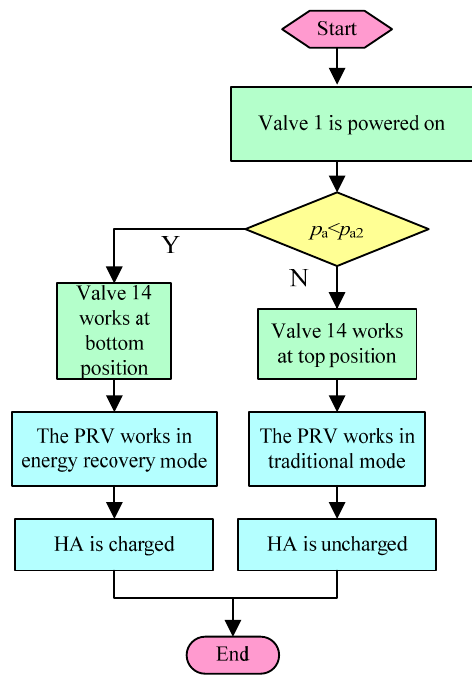
Figure 4. Control flow of the HERU.